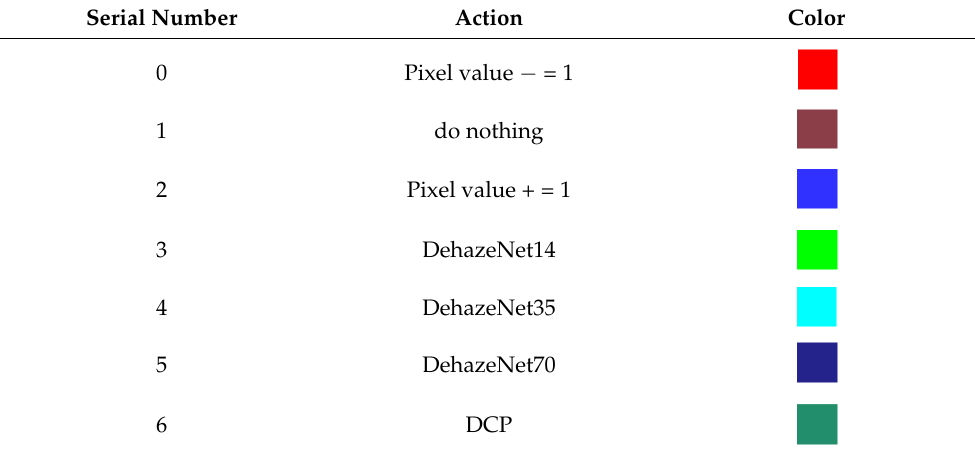
Table 2. Action set used in DRL_Dehaze.